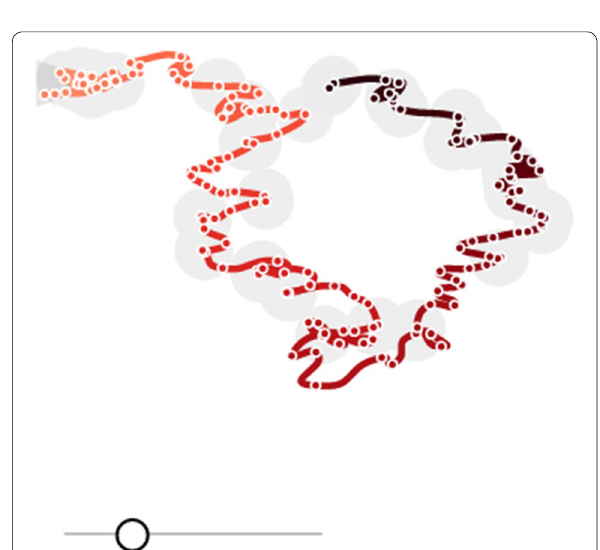
Fig. 5 An example of a TimeCurve. The location of points on the plane is influenced by the underlying temporal measures. Cycles represent repeating patterns, in which close points or tightly clustered sections are highly similar. The bar at the bottom adjusts the level of curvature